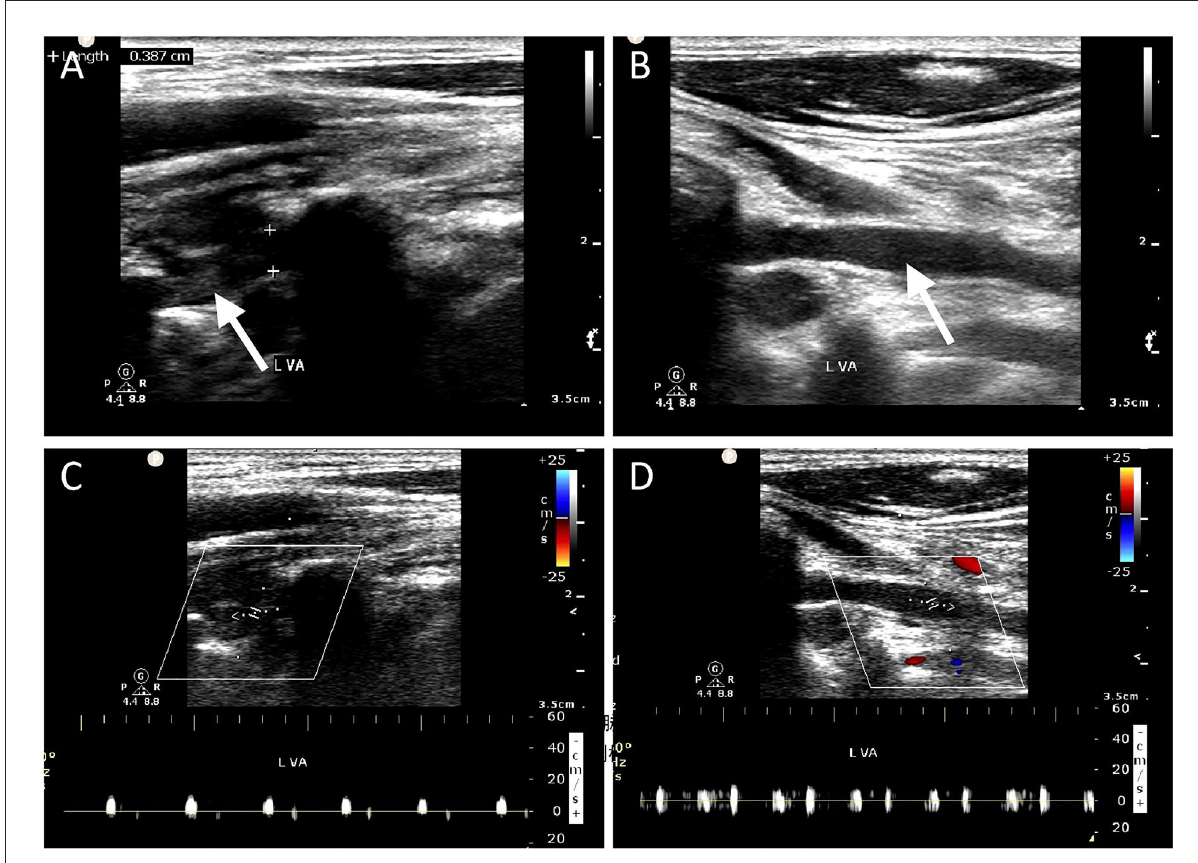
FIGURE2 Ultrasonographic imaging for one case (Patient # 5) with left vertebral artery dissection. The 40-year-old man who had a history of falling down from a freight car 1 day ago presented with sudden syncope on admission. (A) Gray scale ultrasound examination reveals heterogeneous